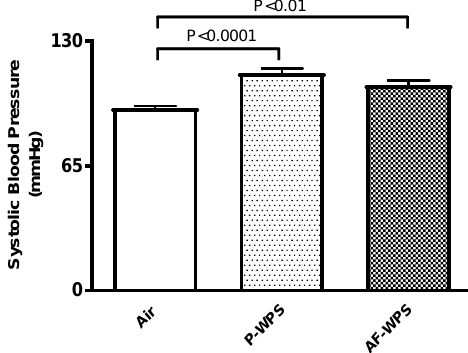
Figure 1. Effects of plain water-pipe smoke (P-WPS) or apple-flavoured (AF)-WPS on systolic blood pressure. Systolic blood pressure measured in mice at the end of 1 mo exposure period to either air or P-WPS or AF-WPS. Data are mean ± SEM (n = 6); one-way ANOVA followed by Holm–Sidak’s multiple comparison